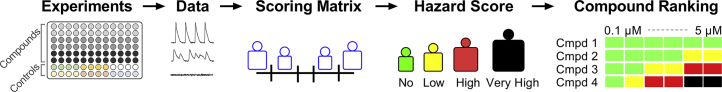
Concept of Cardiac Hazard IdentificationCompounds were tested in hiPSC-CMs using a calcium fluorescence imaging assay. Effects on hiPSC-CMs are evaluated through different parameters, which are then fed into a scoring matrix that translates the data into a hazard level. This approach allows a concentration-dependent hazard identification and ranking of drug candidates.